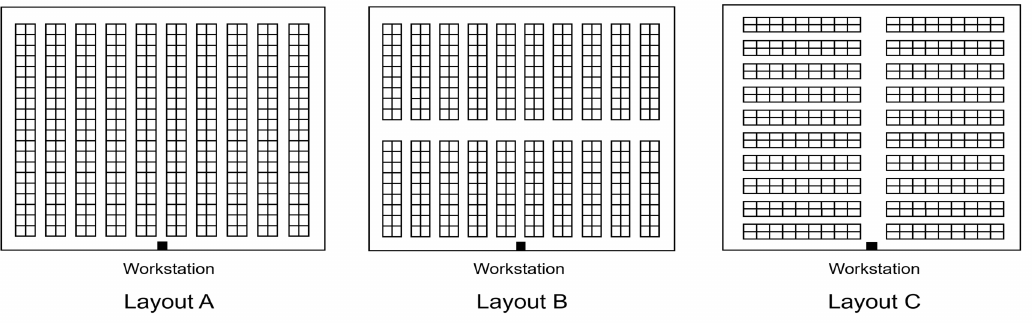
Figure 1. Three most common warehouse aisle